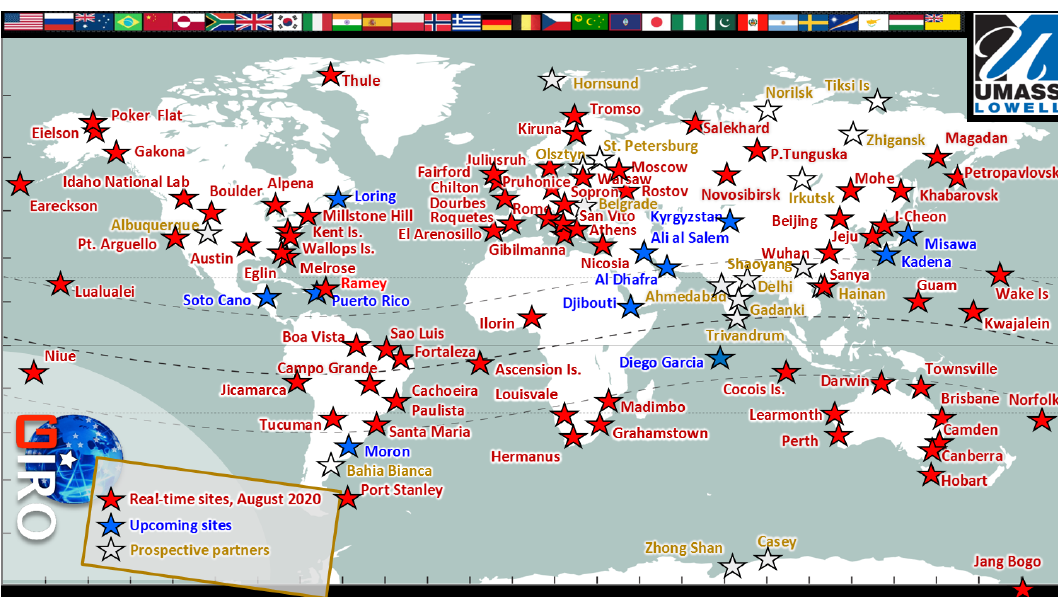
Figure 3. Global GIRO ionosondes distribution as shown at http://giro.uml.edu/ The GIRO products are interpolated over the whole globe, which may lead to slightly lower quality of the data over the areas with lower station density.